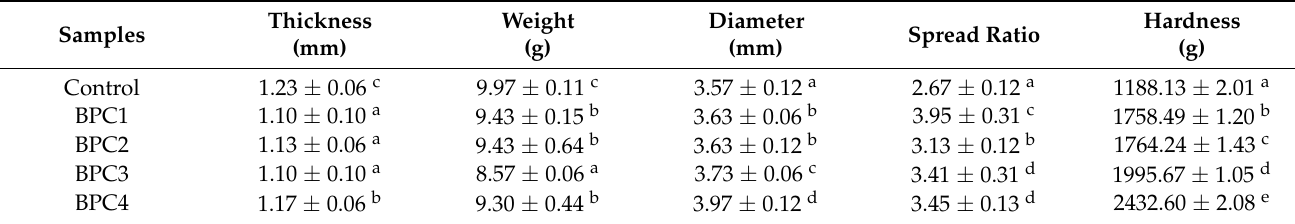
Table 6. Physical properties of composite